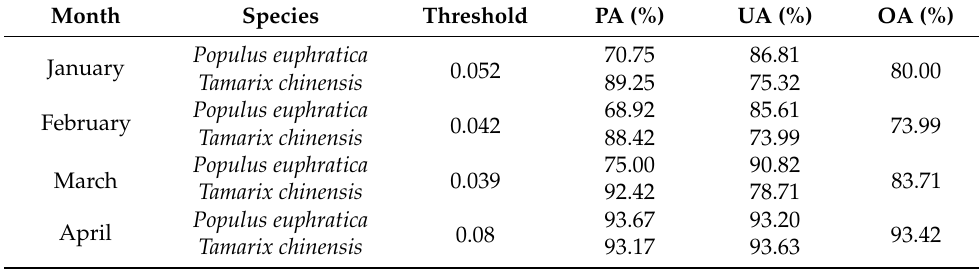
Figure 5. Inverted red-edge chlorophyll index (IRECI) frequency distribution of Populus euphratica and Tamarix chinensis reference pixels in the monthly Sentinel-2 images. Table 3. Comparison of the overall classification accuracy in each month of the analyzed year.